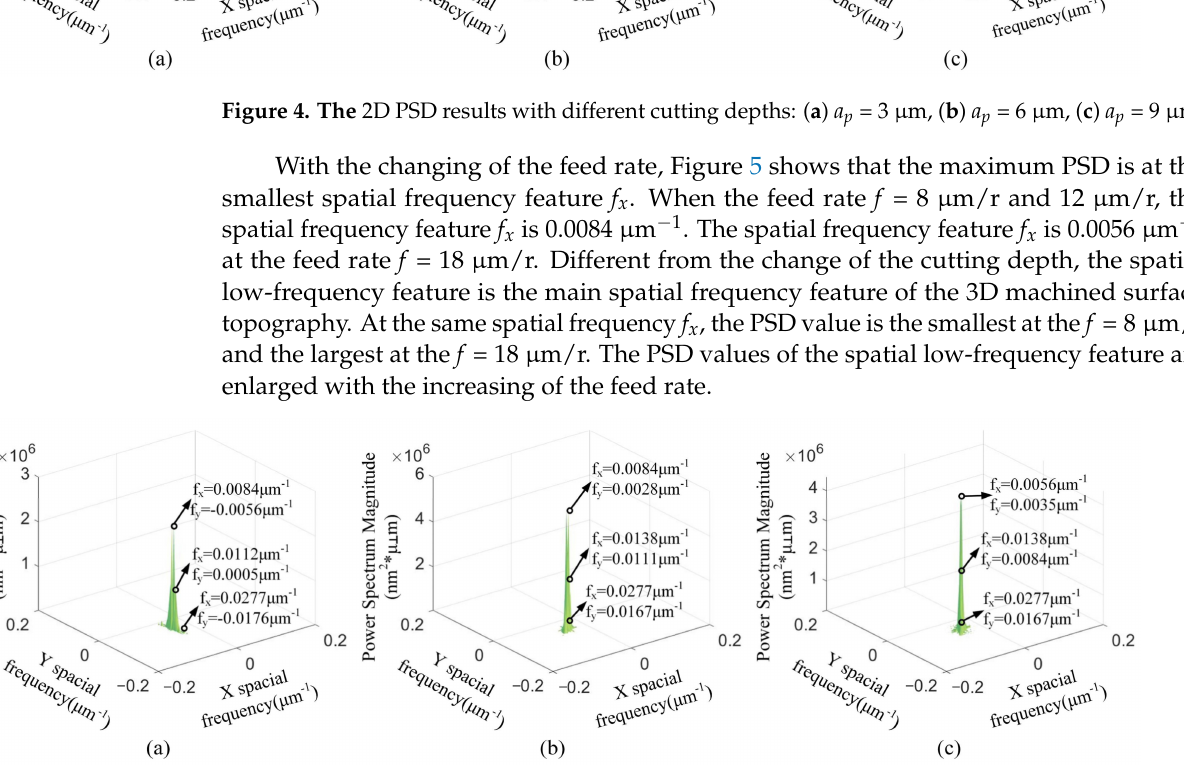
Figure 5. The 2D PSD results with different feed rates: ( a ) f = 8 µ m/r, ( b ) f = 12 µ m/r, ( c ) f = 18 µ